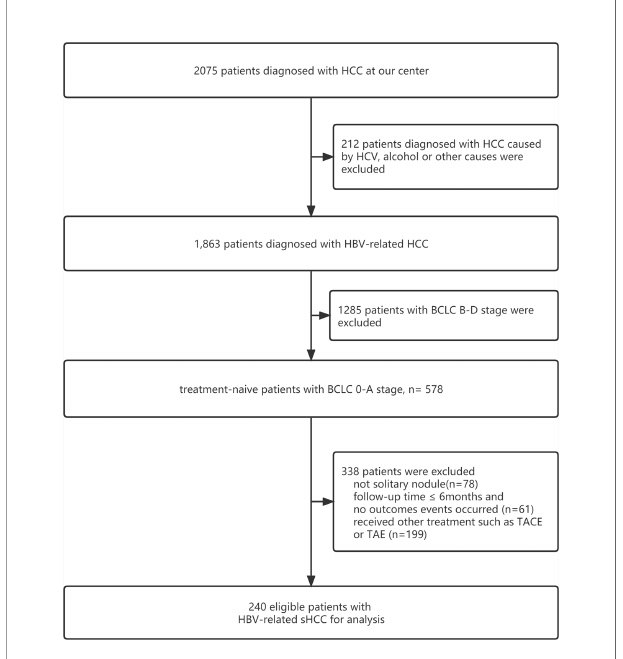
FIGURE 1 | Flowchart of patients and study